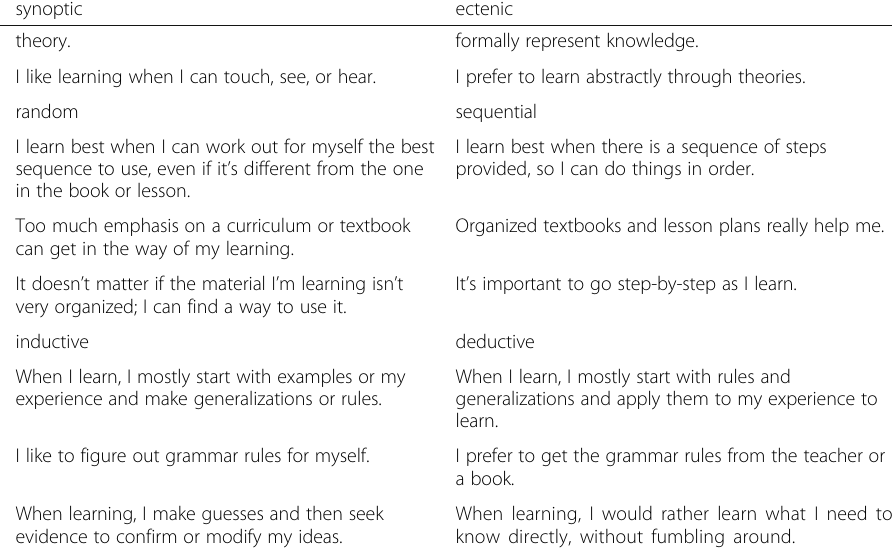
Table 5 The Ehrman and Leaver Learning Style Questionnaire (Ehrman & Leaver, 2002) (Continued)